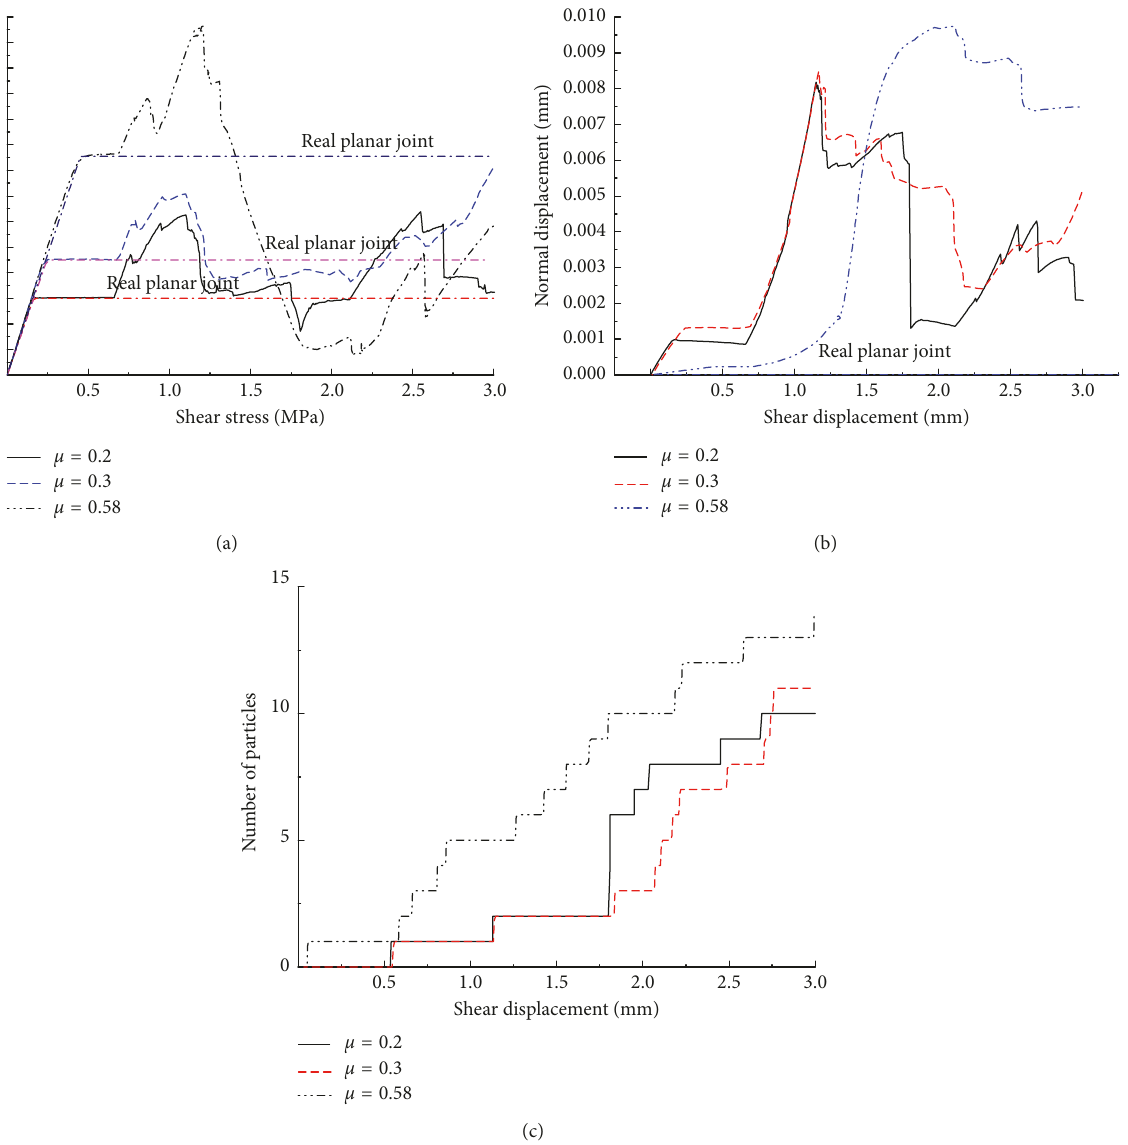
Figure 6: (a) Curves of the shear stress and displacement; (b) curves of the normal and shear displacement; (c) number of particles across the jointed plane.